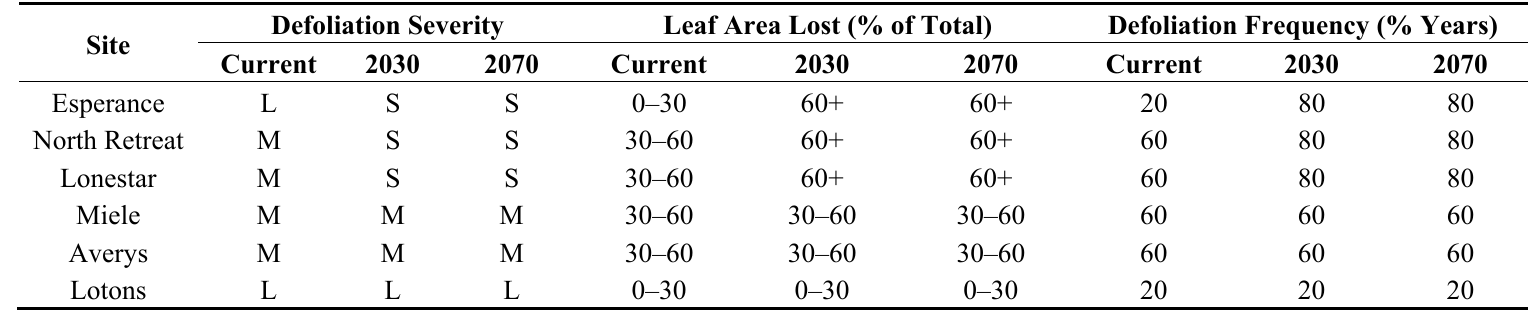
Table 2. The anticipated severity and frequency of defoliation by Mycosphaerella leaf disease at six E. globulus sites in southern Australia based on climatic suitability modelled using CLIMEX [48], and the anticipated leaf loss associated with each defoliation severity. Defoliation severity was estimated using the Hadley Mk2 climate model. This information was used to develop defoliation scenarios in CABALA. L = low, M = moderate, and S = severe